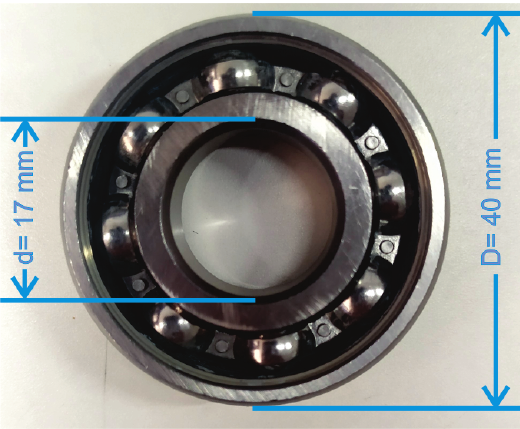
Figure 5. Metallic rolling bearing model 6203 2RS, used during